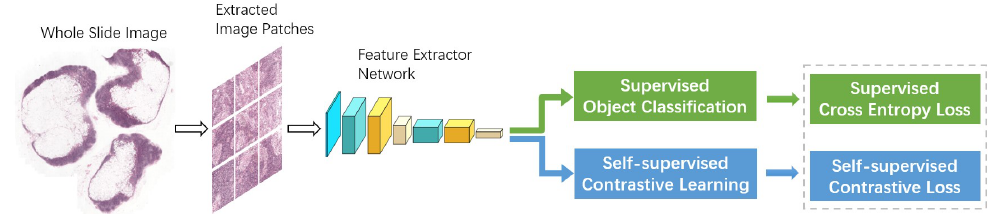
Figure 1. Overview of the proposed